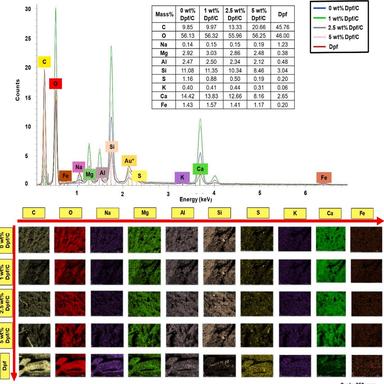
Line graph and elemental mapping illustrating the atomic compositions of different ratios of Dpf/C and Dpf alone.